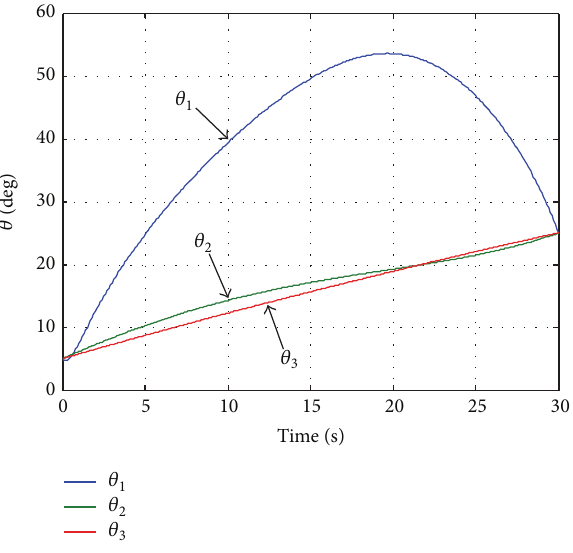
Figure 7: Joints angular displacement at 𝜑 2 = 34 ∘ (simulation